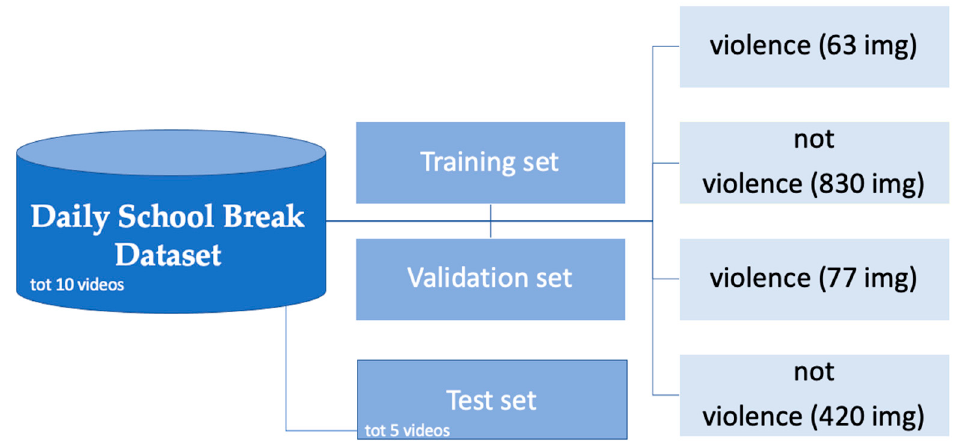
Figure 3. Logical architecture of the Daily School Break dataset.